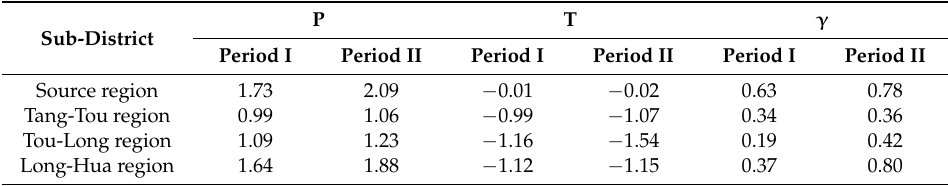
Table 7. Sensitivity of streamflow to various elements in four regions.